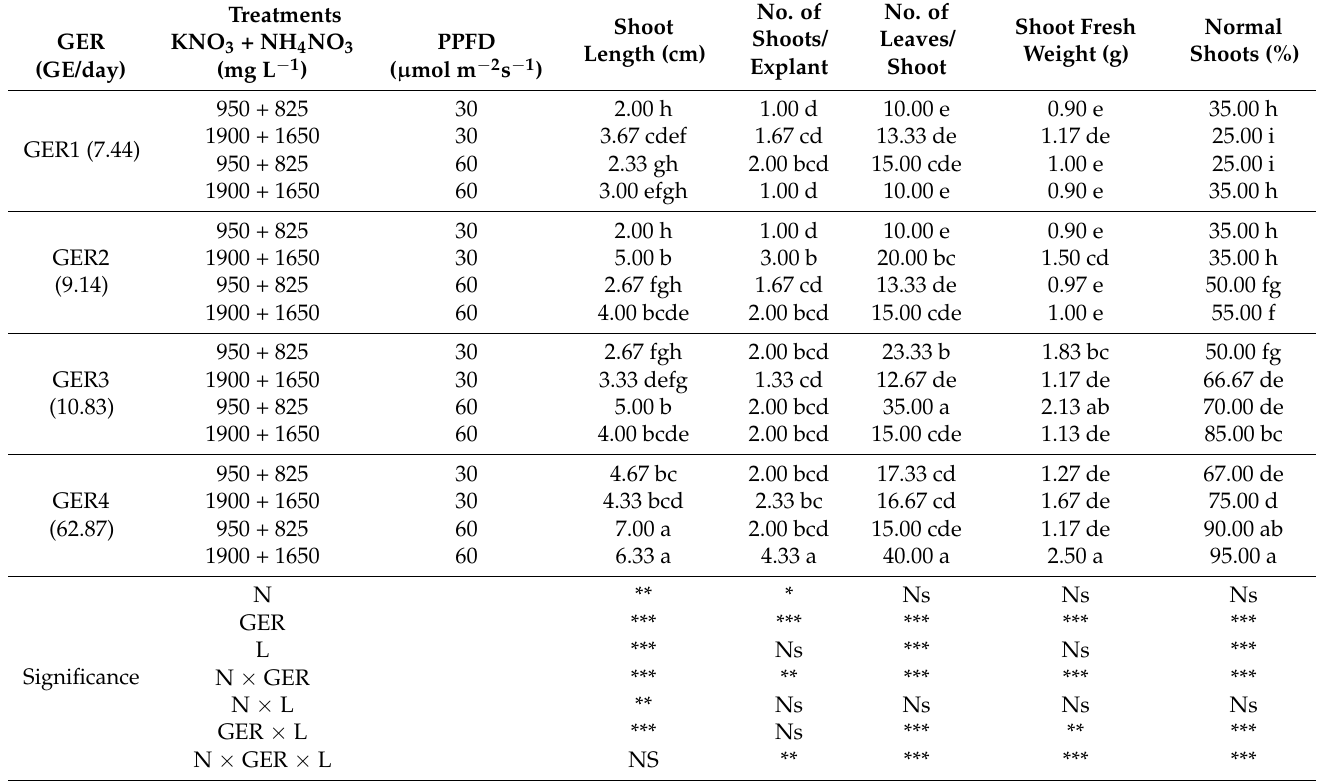
Table 5. Effect of gas exchange rate, nitrate salts and light density on growth and hyperhydricity reversion of G. paniculata in vitro shoots after four weeks. All media were fortified with 2 mg L − 1 paclobutrazol and solidified with 9 g L − 1